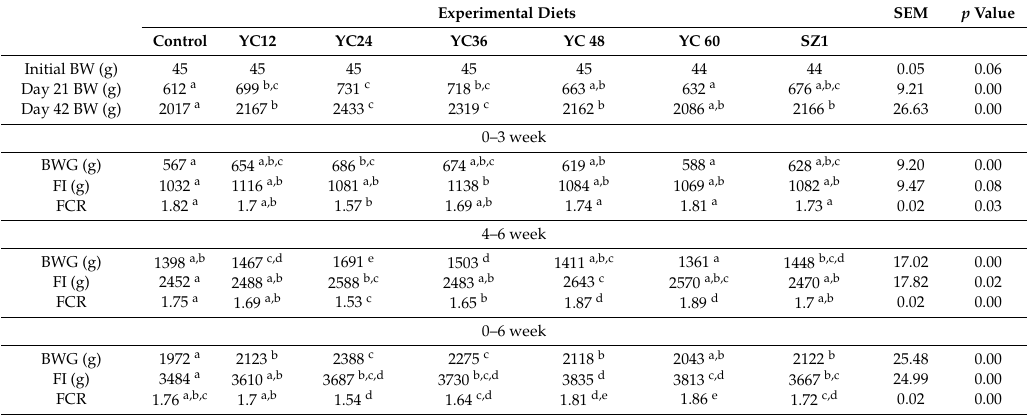
Table 3. Growth performance of broilers fed diets containing di ff erent YCs from week 0 to week 6. Experimental